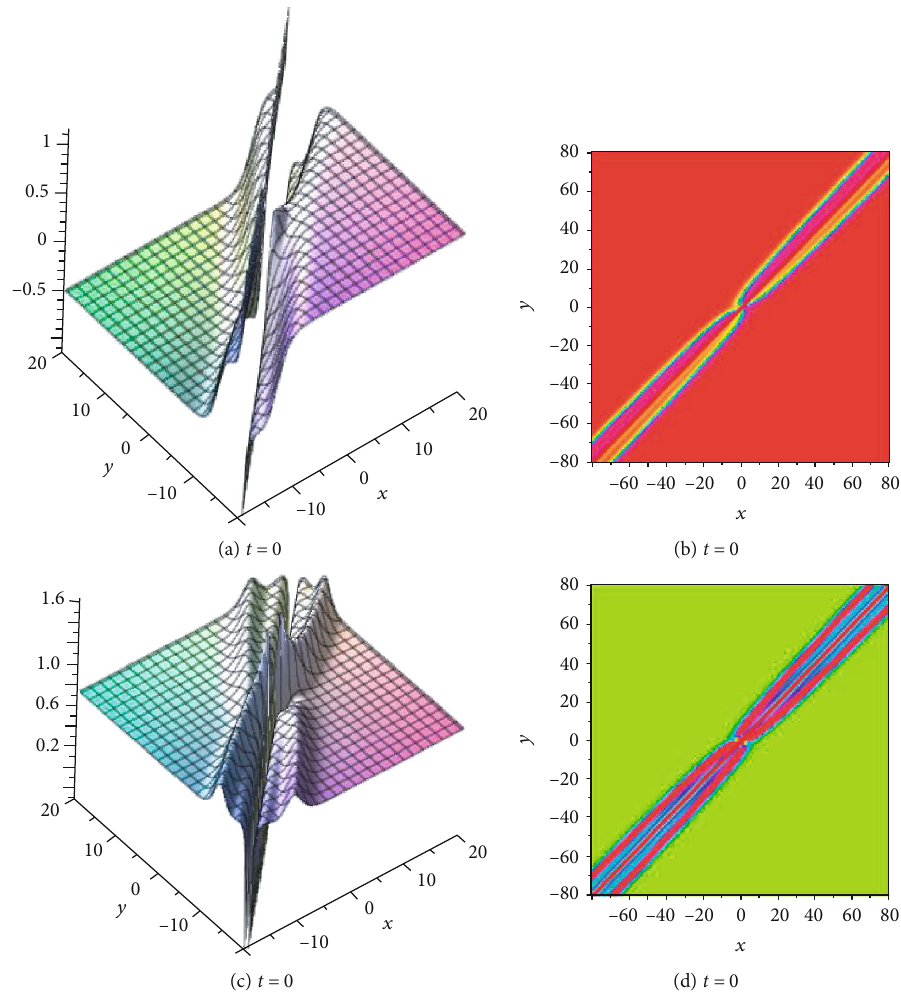
= 1 , a = 0 , a = 2 , a = 1 , a = 0 , a = 1 , α = 1 , β = 1 , 1 4 6 7 8 9